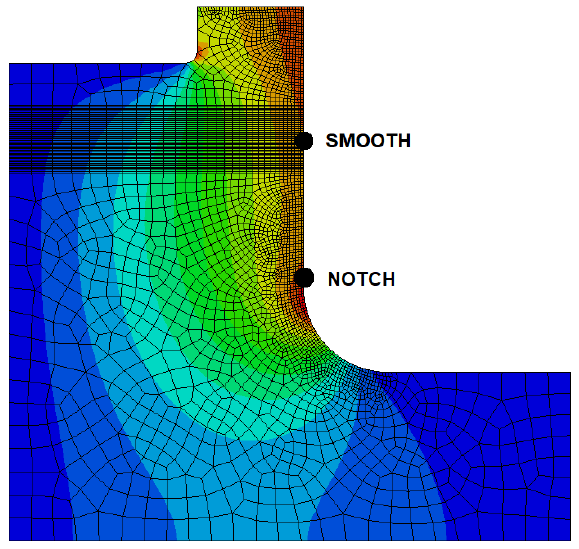
Figure 3. Axisymmetric model of part of the output shaft used for virtual calibration.